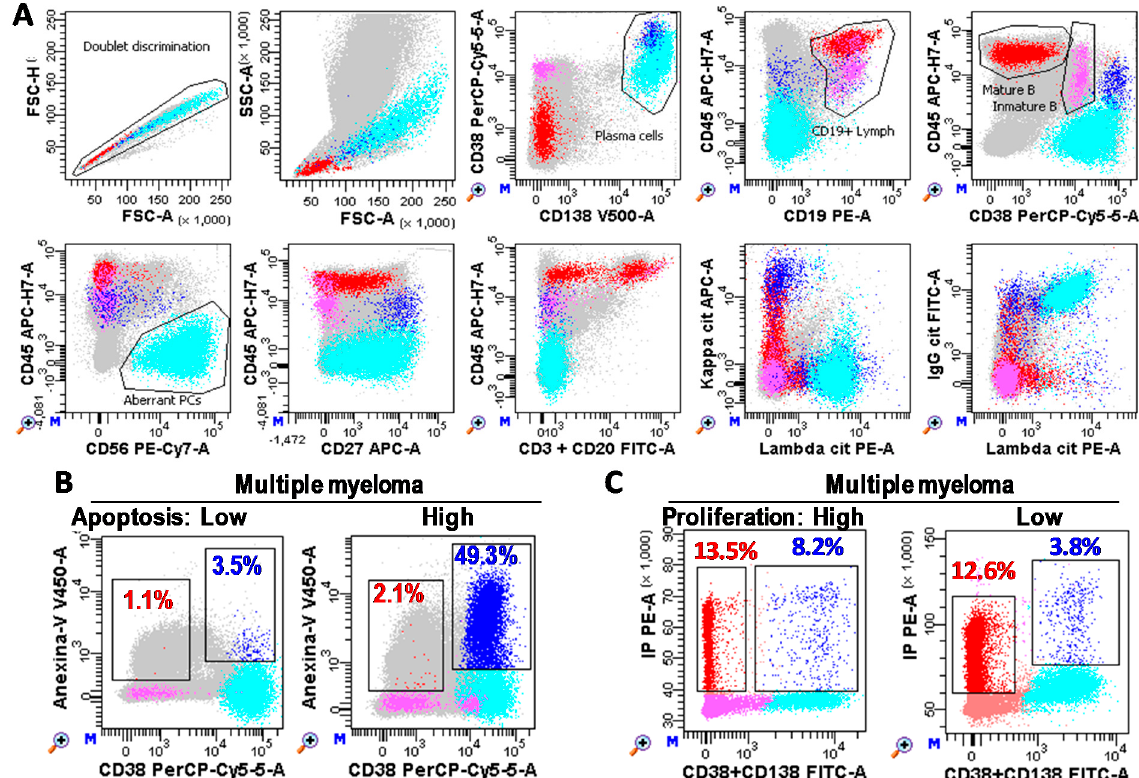
Figure 7. Plasma cell (PC) immunophenotyping. ( A ) Flow cytometry analysis of bone marrow samples performed with FACSCanto-II and DIVA Software (Becton Dickinson, San Jose, CA, USA). Photomultiplier (PMT) voltages were adjusted daily using CS&T beads (BD). Fluorescence compensations were finely adjusted using negative events as reference for each fluorochrome. A total of three million white cells were stained for each tube, tube-1: CD3&CD20 FITC, CD19 PE, CD38 PerCP-Cy5.5, CD56 PE-Cy7, CD27 APC, CD45 APC-Cy7, Annexin-V V450, and CD138 BV510 (BD); and tube-2: cyIgG, cyIgA, cyIgD, or cyIgM FITC, cyLambda PE, CD38 PerCP-Cy5.5, CD56 PE-Cy7, cyKappa APC, CD45 APC-Cy7, CD19 BV421, and CD138 BV510 (BD). One million cells were recorded for each tube. After doublet discrimination (in a FSC-H/SSC-A dotplot), total PC (Blue) were identified as CD38 +++ CD138 +/++ events. Aberrant PC (cyan) were identified as CD45 low/negative and/or CD19 low/negative and/or CD20 + and/or CD27 low/negative and/or CD56 + and/or monoclonal restriction for the heavy and/or light immunoglobulin chains (specific gating strategy was follow for each patient based on their phenotype). Mature B cells (red) were identified as lymphocytes (FSC/SSClow) CD19 + CD45 ++ CD38 − /+ low. Immature B lymphocytes (pink) were defined as CD19 + CD45 low CD38 ++ . Grey cells are non-B non-PC cells. ( B , C ) Bone marrow PCs (CD38 + CD138 + ) from MM patients with low and high apoptosis (Anexin-V + blue and red events for PCs and B lymphocytes, respectively) and proliferation rates (S + G2/M phases of the cell cycle), respectively.